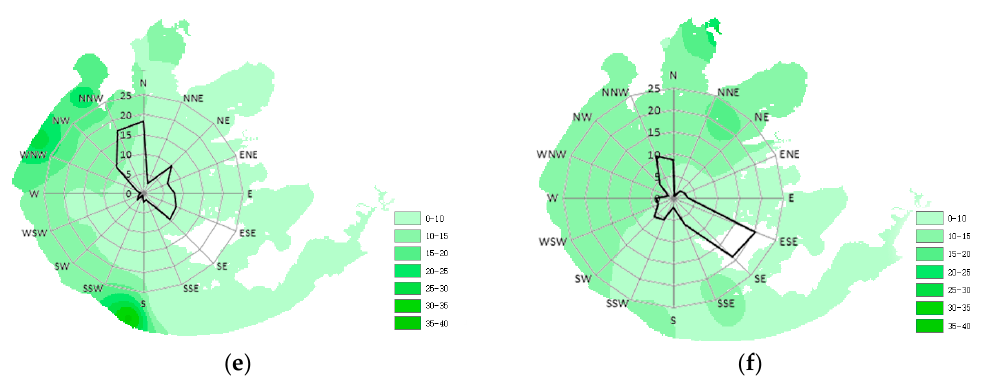
Figure 7. Map showing the spatial distribution of: ( a , b ) mean total nitrogen or TN concentration in mg·L − 1 ; ( c , d ) mean total phosphorus or TP concentration in mg·L − 1 ; and ( e , f ) mean chlorophyll-a or Chl-a concentration in µg·L − 1 , for the year 2005. ( a,c,e ) are for the warm seasons (i.e., spring and summer), while ( b,d,f ) are for the cool seasons (i.e., fall and winter).